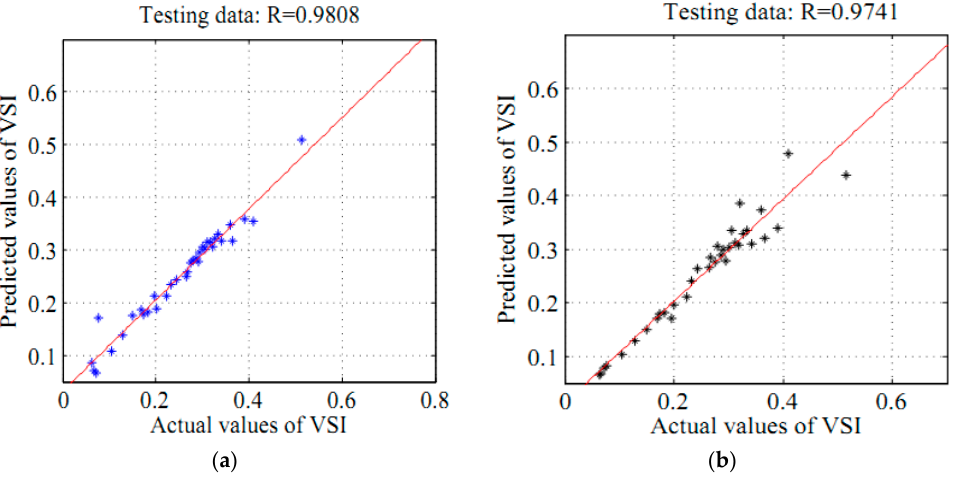
Figure 8. Linear fits between the actual and predicted VSI for IEEE 118-bus in testing phase using ( a ) ALO-SVR; ( b ) ANFIS.